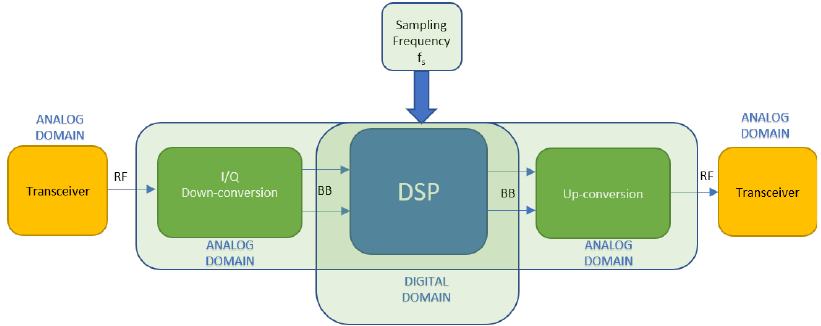
Figure 1. System-level schematic of a generic RF channel